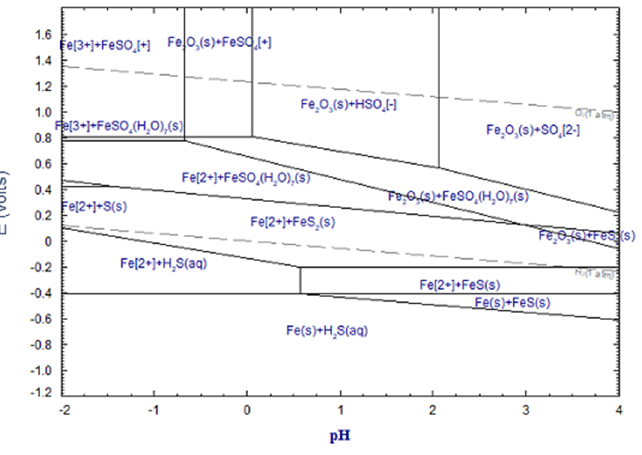
Figure 6. Pourbaix diagram of the Fe-S-H 2 O system elaborated with the FactSage 8.0 software.